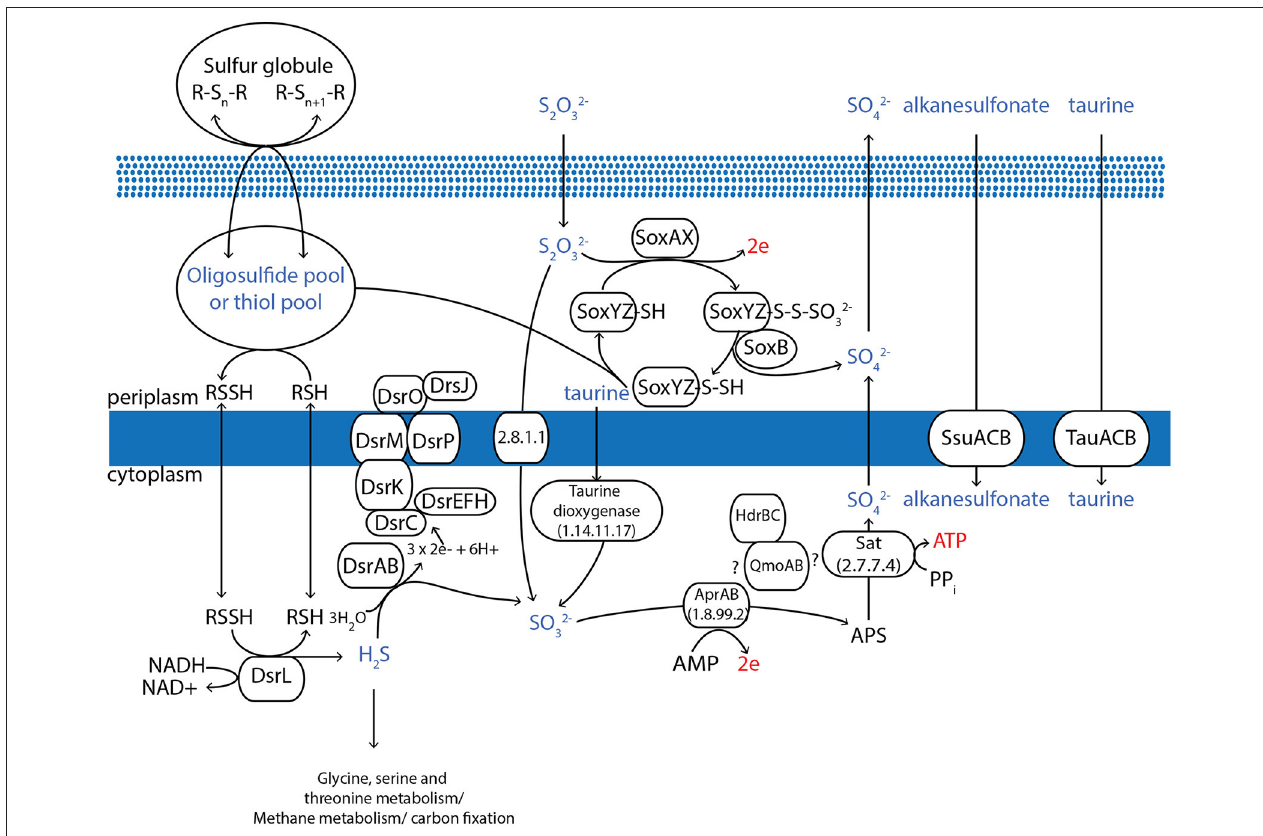
FIGURE 3 | Overview of the proposed pathways for the oxidative sulfur metabolism of AqS1. All of the genes depicted in the figure are identifiable in the genome assembly. Specifically, AqS1 contains a Sox enzyme complex for periplasmic oxidation of reduced sulfur compounds, coupled with a reverse dissimilatory sulfate reduction pathway for sulfide oxidation in the cytoplasm. The AqS1 genome also includes other genes that can process extracellular taurine, alkanesulfonate and dimethylsulfoniopropionate, all of which can contribute to sulfide incorporation into carbon. Figure adapted from Frigaard and Dahl